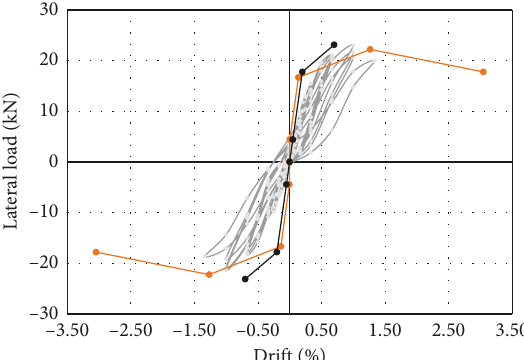
Figure 13: Comparison between experimental data and theoretical models for specimen RCW4.